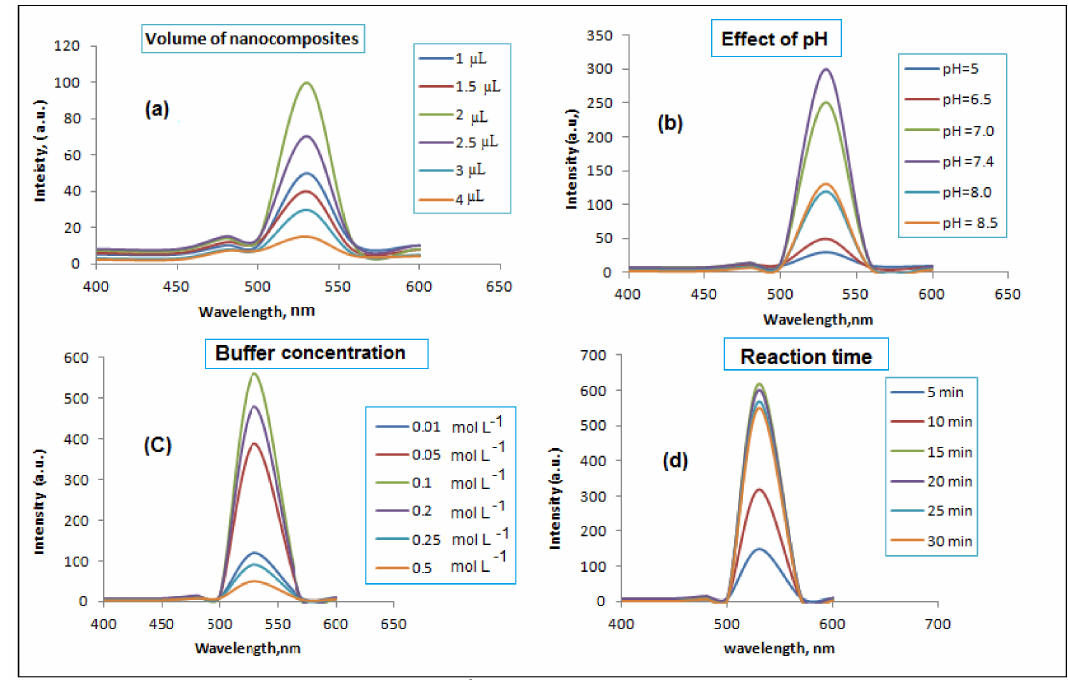
Figure 7. Optimization of fluorescence detection conditions at λ ex = 420 and λ em = 530 nm: ( a ) effect of nanocomposite volume, ( b ) effect of pH value, ( c ) effect of buffer concentration, ( d ) effect of reaction time.